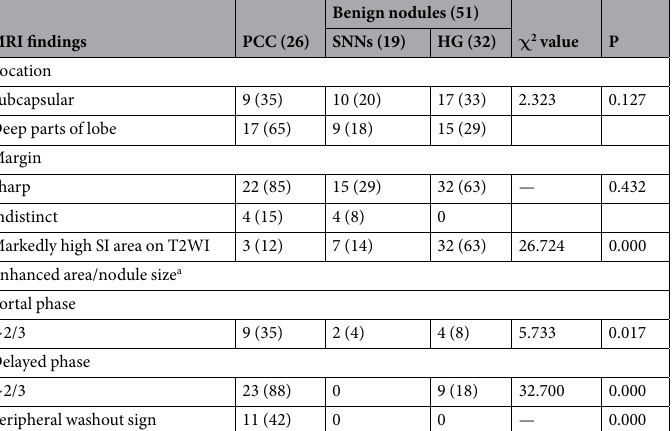
Table 2. MRI findings of peripheral cholangiocarcinoma and benign hepatic hypovascular nodules. Note: a, Estimate at the maximum cross-sectional area. Data are presented as the number of patients with percentage in parentheses. Percentages are calculated on the basis of each group. SI, signal intensity. A difference with p < 0.05 was considered to be statistically significant for the Chi-square test, and the Fisher’s exact test was used to compare each MRI finding between the PCC and benign groups. PCC, peripheral cholangiocarcinoma. SNN, solitary necrotic nodules. HG, hepatic hemangioma. SI, signal